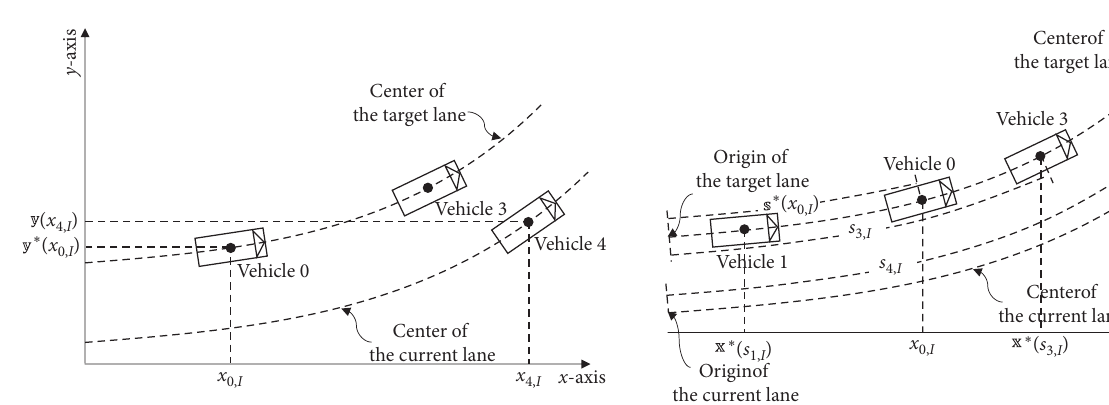
Figure 3: Road curve functions and curve distance.